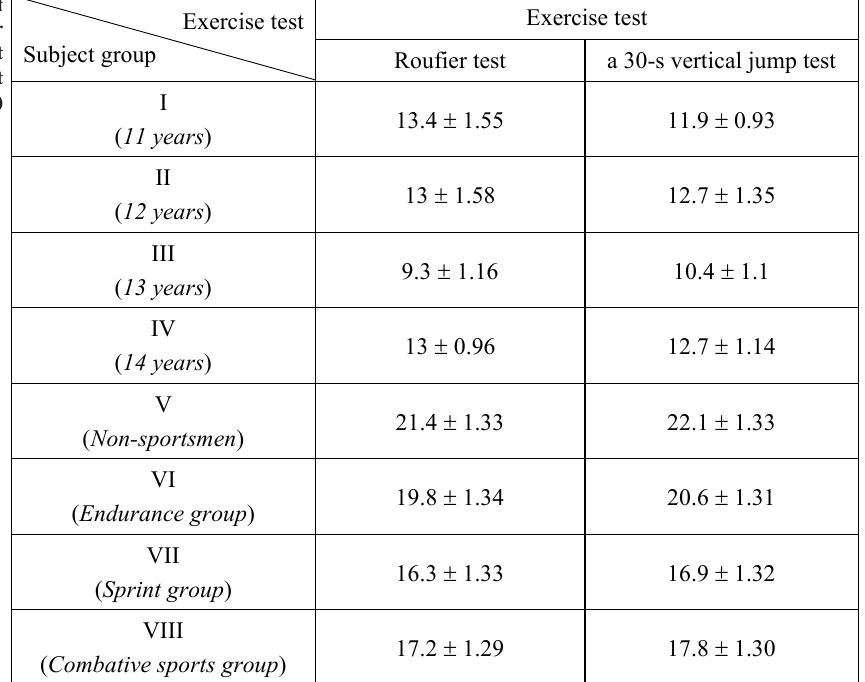
Table 2. The values in velocity of ) of cardiovascular adaptation (V Ad system at onset of Roufier’s test (aerobic workout), 30 second all-out test in jumping (anaerobic